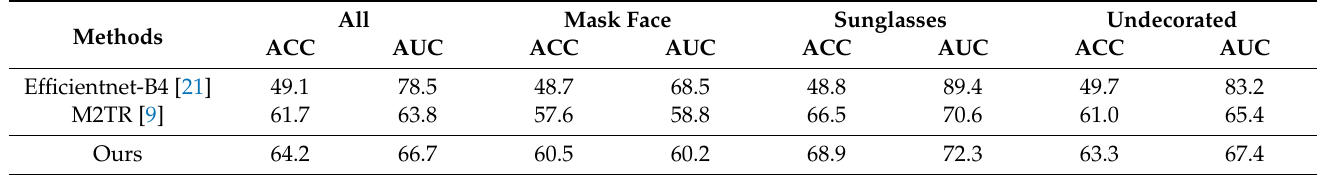
Table 4. Cross-dataset evaluation results on FOFDTD (GAN-generated) dataset (ACC% and AUC%).